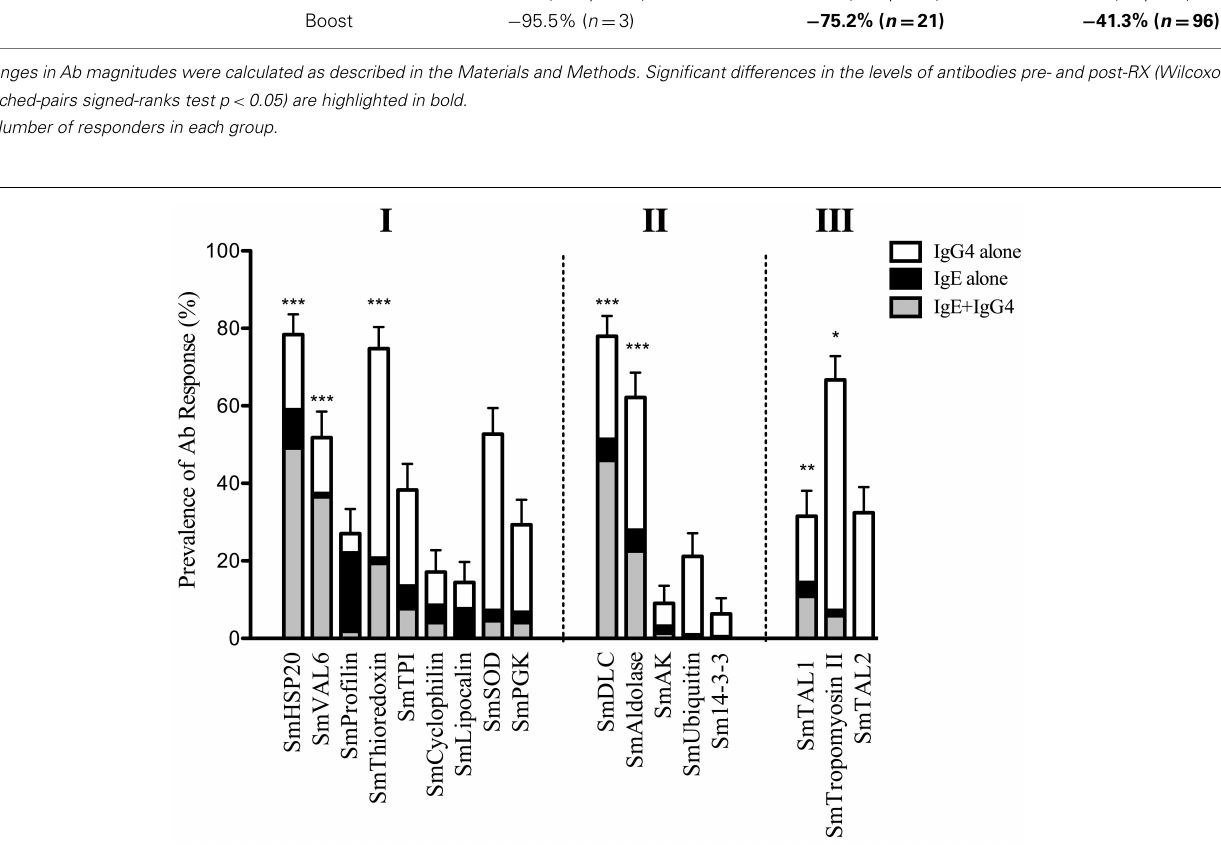
FIGURE 3 | Proportions of individuals responding with IgE alone, IgG4 alone, or IgG4 and IgE together post-treatment with PZQ . Prevalences/proportions of responders were calculated following the application of assay sensitivity cut-offs (mean + 3 σ ) determined using sera from 26 normal European controls.Two-sample test of proportions was used